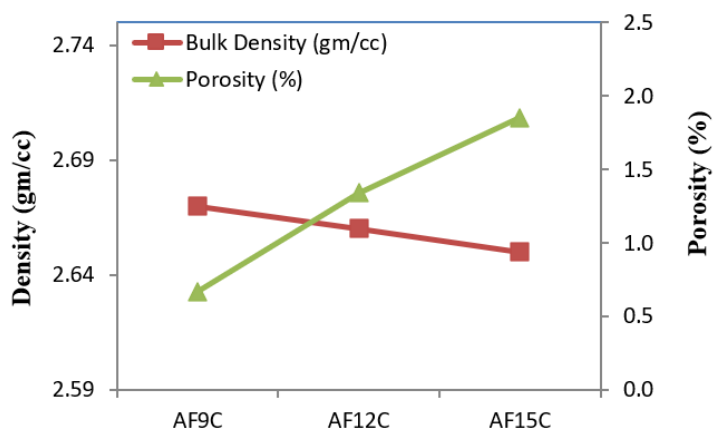
Figure 7. The measured density and porosity of nanocomposite.